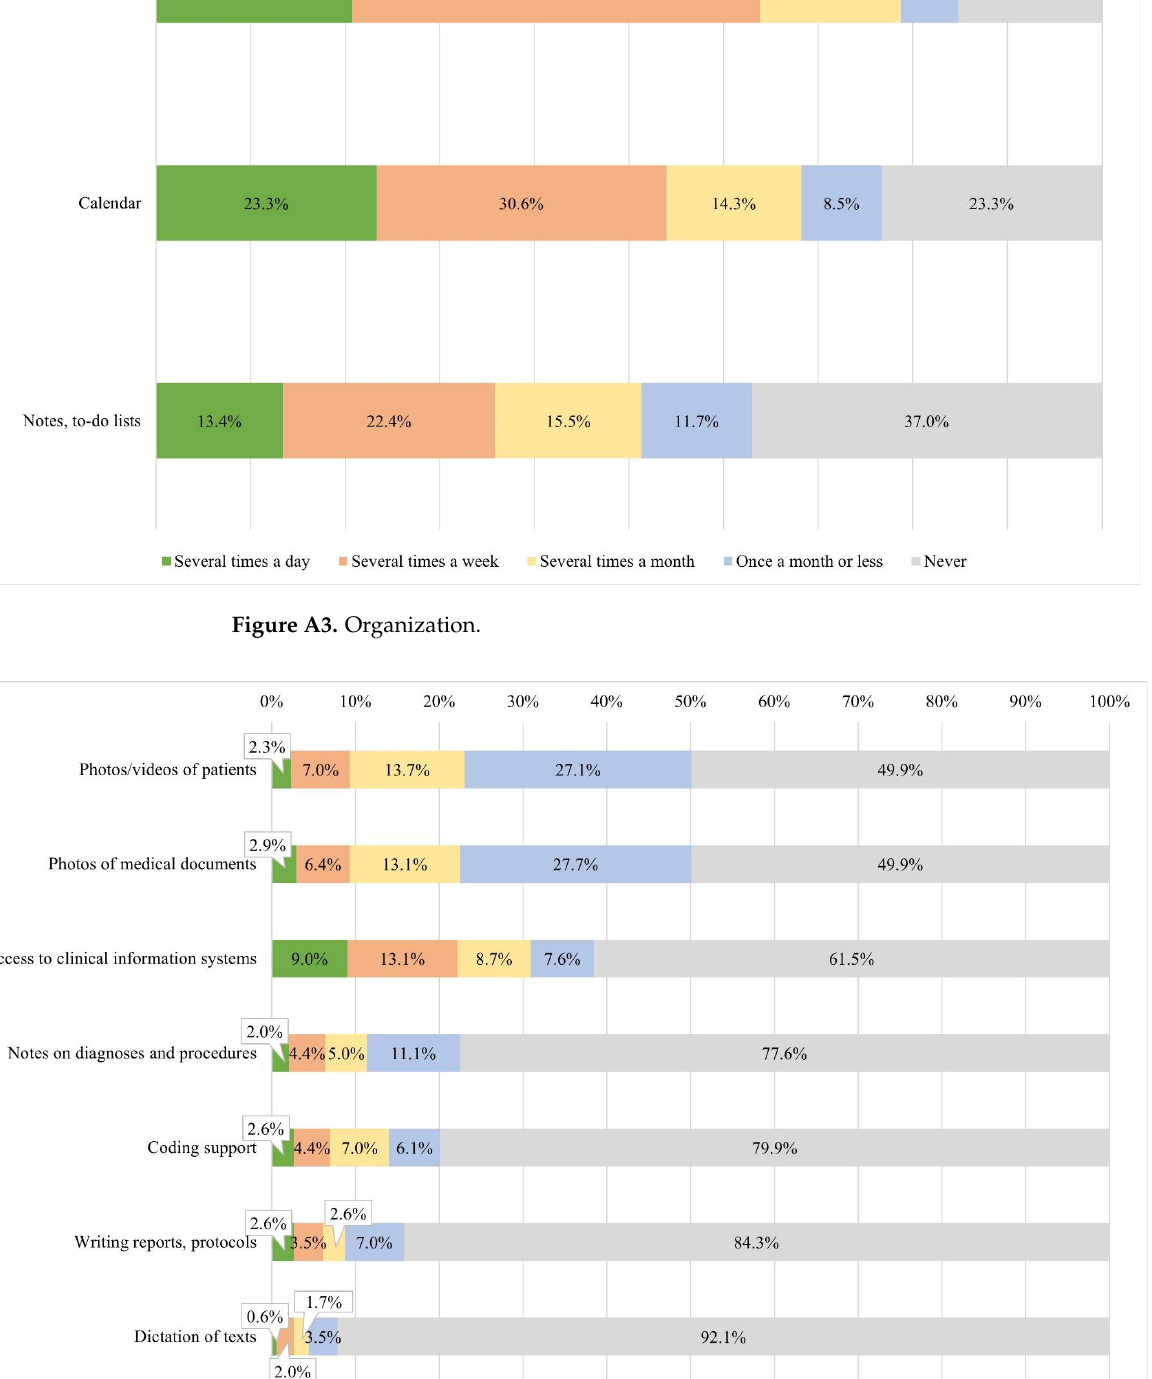
Figure A4. Documentation and Monitoring.